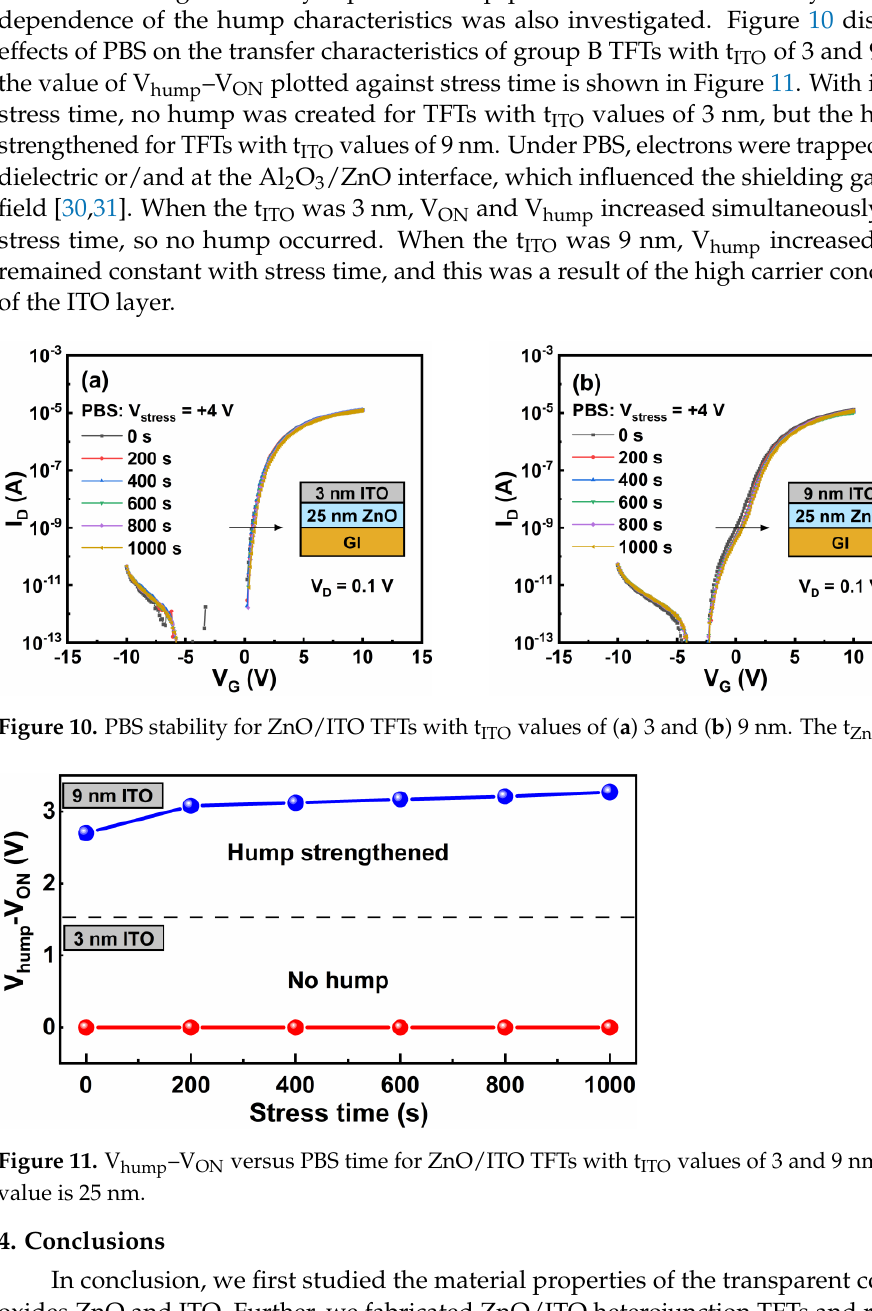
Figure 9. Schematic diagrams of current conduction in channel structures of ( a ) ZnO/ITO (10 nm/9 nm), ( b ) ZnO/ITO (40 nm/9 nm), ( c ) ZnO (25 nm)/ITO (≤5 nm), and ( d ) ZnO (25 nm)/ITO (>5 nm).